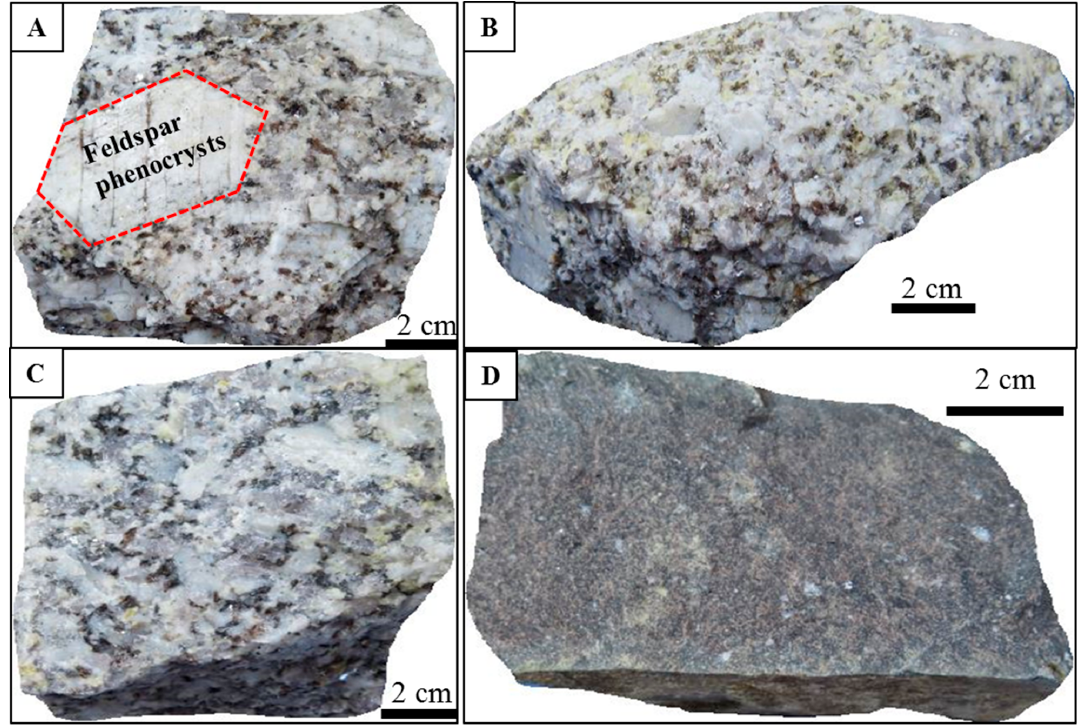
Figure 3. Photographs showing hand specimens of the Tagu tin–tungsten deposit. ( A , B , and C ): Hand specimen of porphyritic granitic rock, which includes feldspar phenocrysts; ( D ). hand specimen of greywacke .